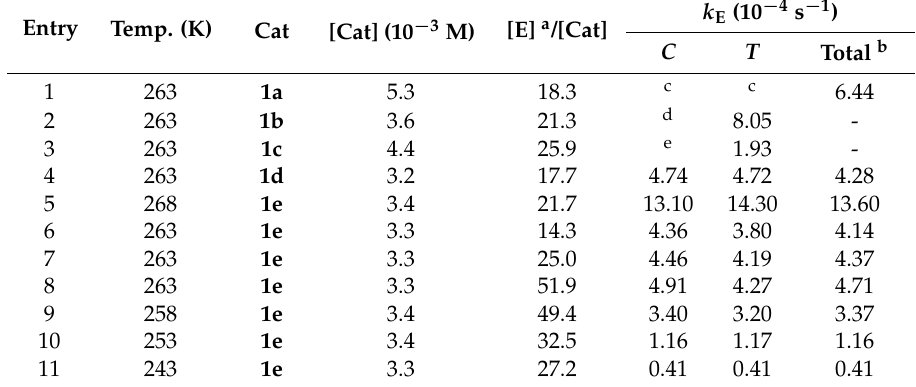
Table 4. Kinetic data for the pseudo-first-order k E of ethylene insertion reaction of 1a – e in CDCl 3 . Entry Temp. (K)